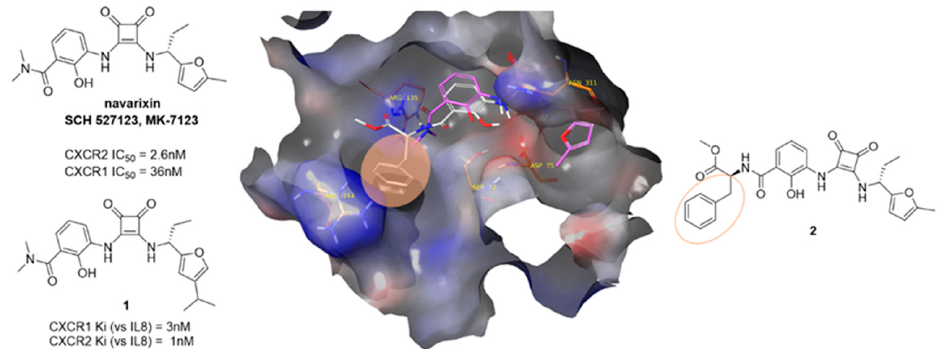
Figure 16. (left) Navarixin, currently the most advanced CXCR2 intracellular allosteric antagonist and ( 1 ) the most potent dual CXCR1/CXCR2 intracellular allosteric antagonist. (right) Proposed novel binding site extension between TM3 and TM5 in CXCR1. Overlayed docking of navarixin and proposed novel analogue ( 2 ) shows similar docking pose with the phenyl ring of the analogue buried in the receptor (highlighted orange).